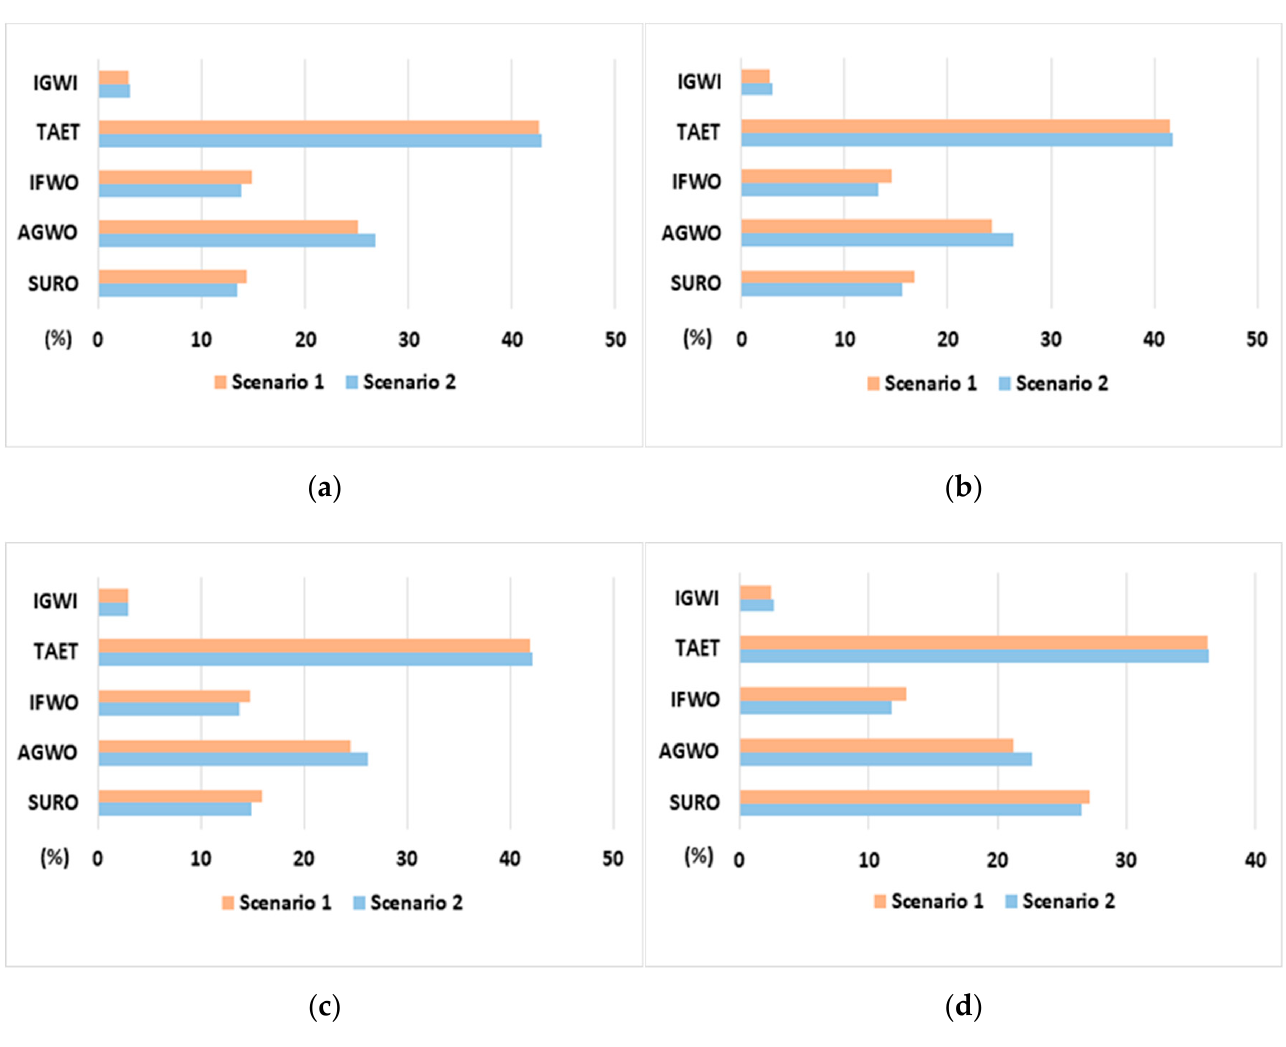
Figure 7. Comparison of hydrologic components of four sub-watersheds from two scenarios. (IGWI, Inflow to Inactive Groundwater; TAET, Total Simulated Evapotranspiration; IFWO, Intermediate Outflow; AGWO, Active Groundwater Outflow; SURO, Surface Outflow.) (( a ) Chuncheon Dam—downstream; ( b ) Soyanggang Dam—downstream; ( c ) Uiam Dam; ( d ) Gongji Stream). Table 6. Hydrologic components for each land use from Scenario 1.